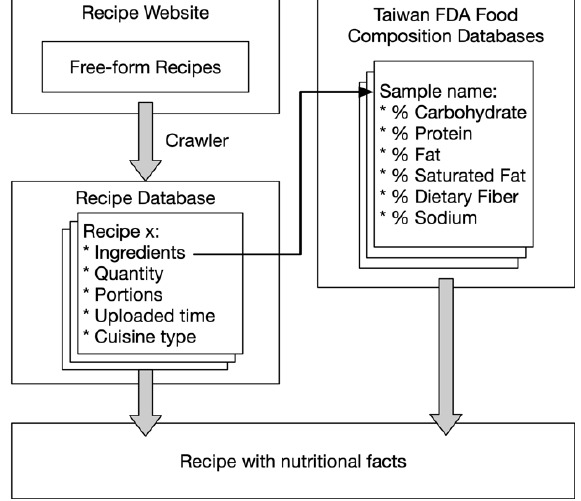
Figure 2. Linkage of online recipes and nutritional database to include rich nutrition information.